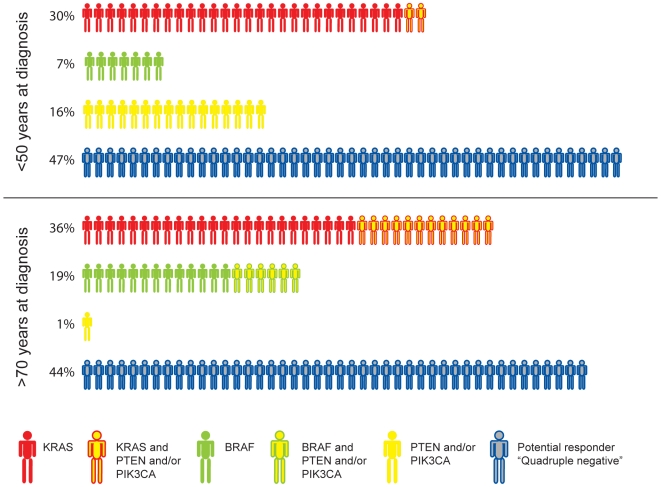
Graphic representation of patients with hypothesized response to EGFR-targeted therapy.Percent-wise distribution of aberrations for KRAS, BRAF, PIK3CA and PTEN and their combinations, in the <50 age group and >70 age group. Patients negative for all mutations (quadruple negative) are potential responders to anti-EGFR-therapy. (Modified from Bardelli et al.
[29])